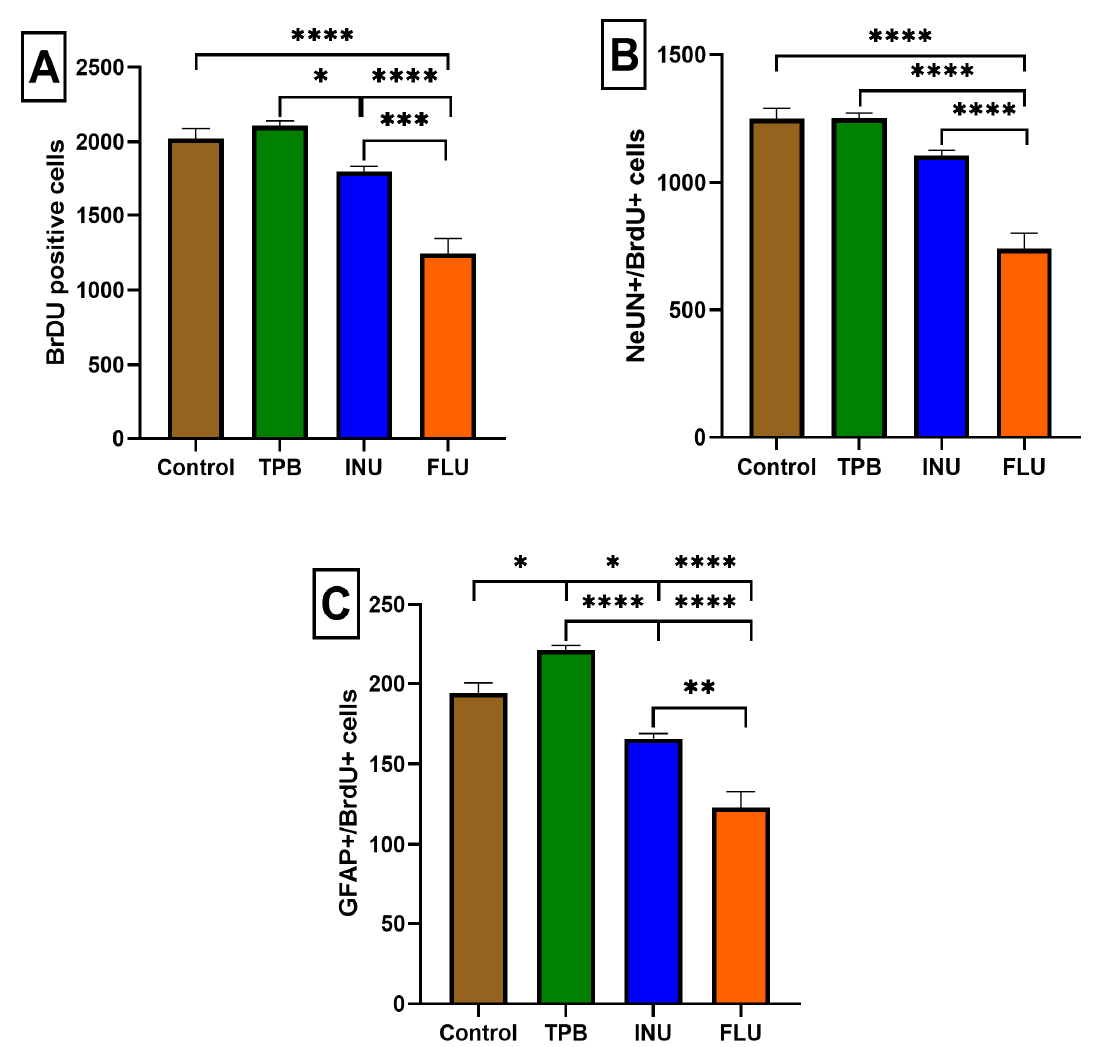
Figure 6C). Representative images of immunohistochemical changes for each of the study groups (control, TPB, INU, FLU) were included in the Supplementary File (Figures S1–S4).